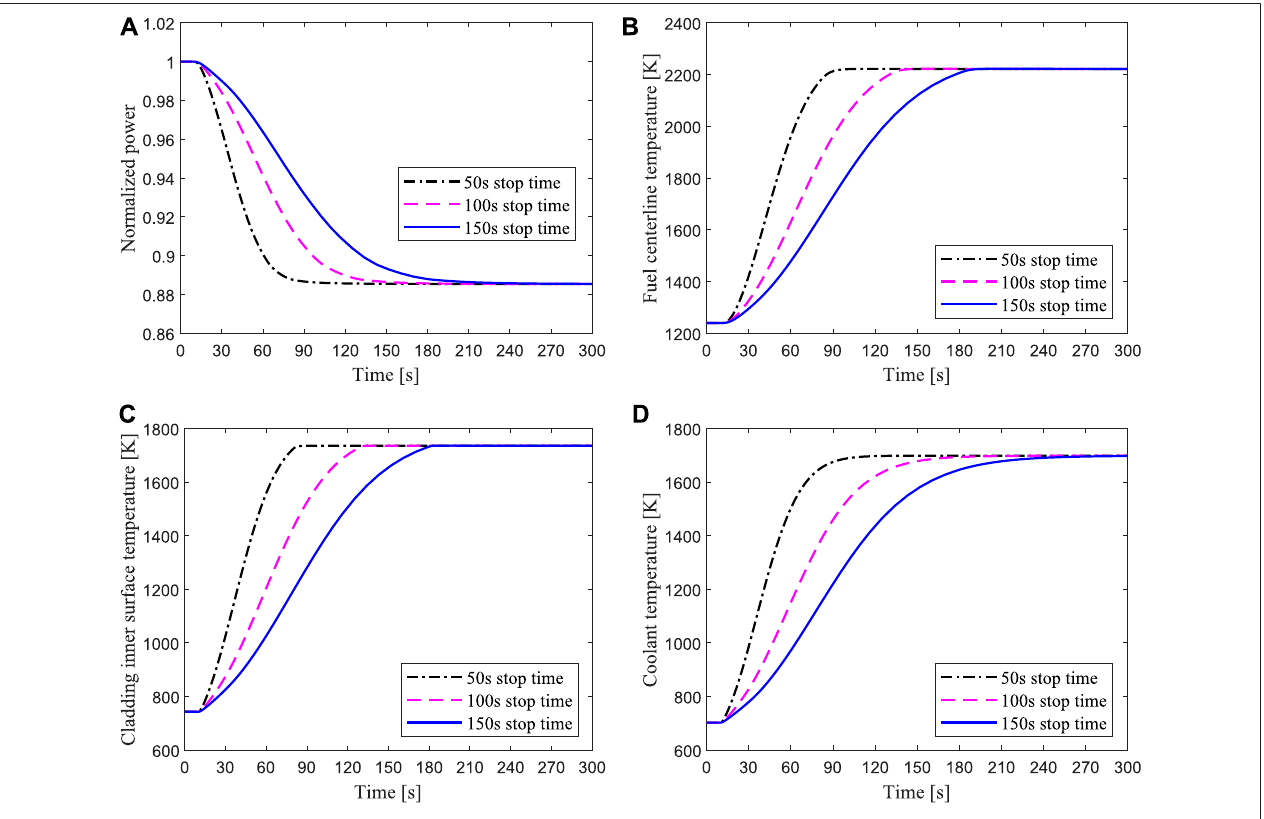
FIGURE 14 | Transient responses of the hottest channel for unprotected loss of fl ow due to 50, 100, 150 s pump coastdown respectively.